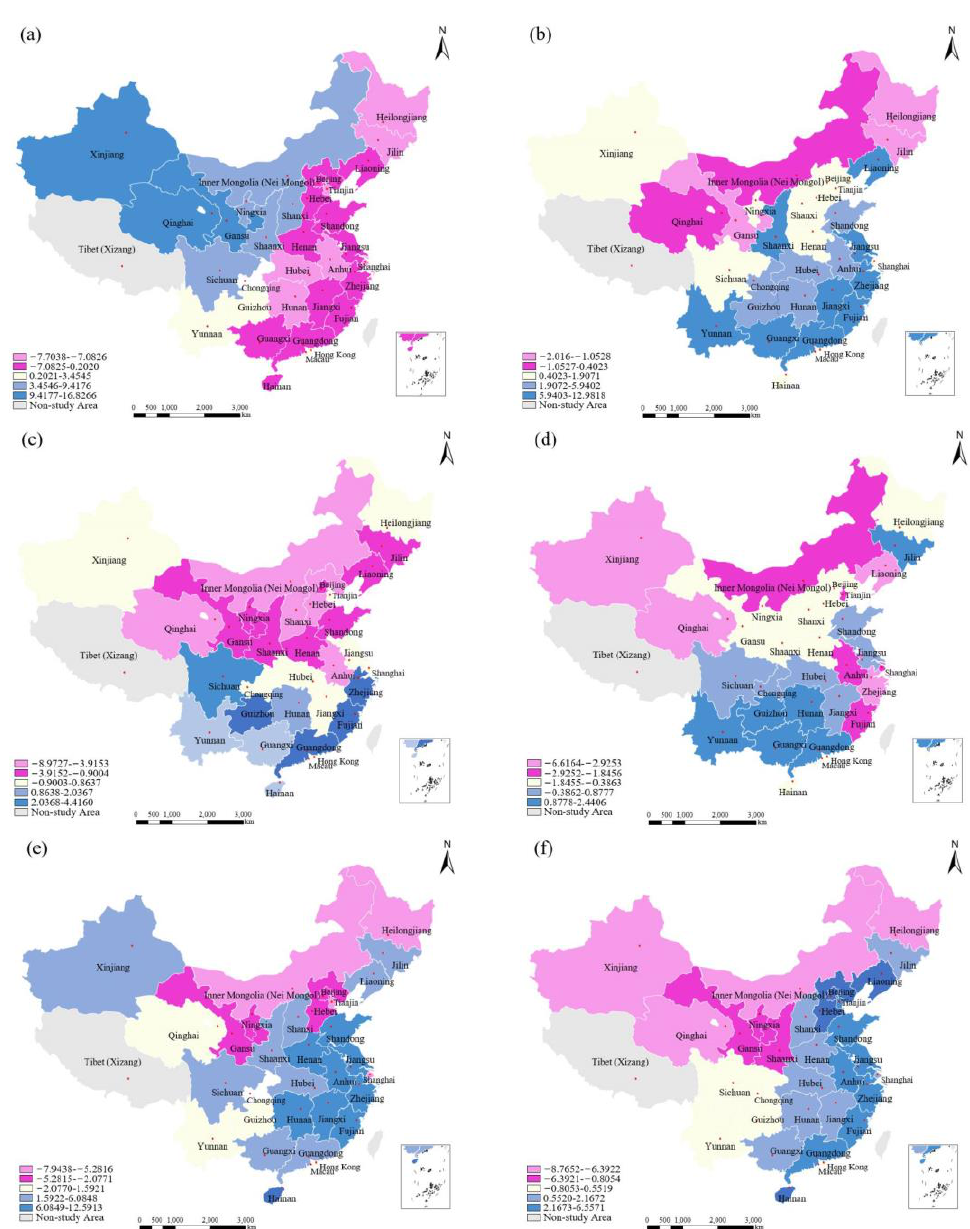
Figure 6. Spatial distribution patterns of the driving factor for ( a ) POD, ( b ) GDP, ( c ) TM, ( d ) UR, ( e ) AGDP, and ( f ) R&D expenditure, respectively.